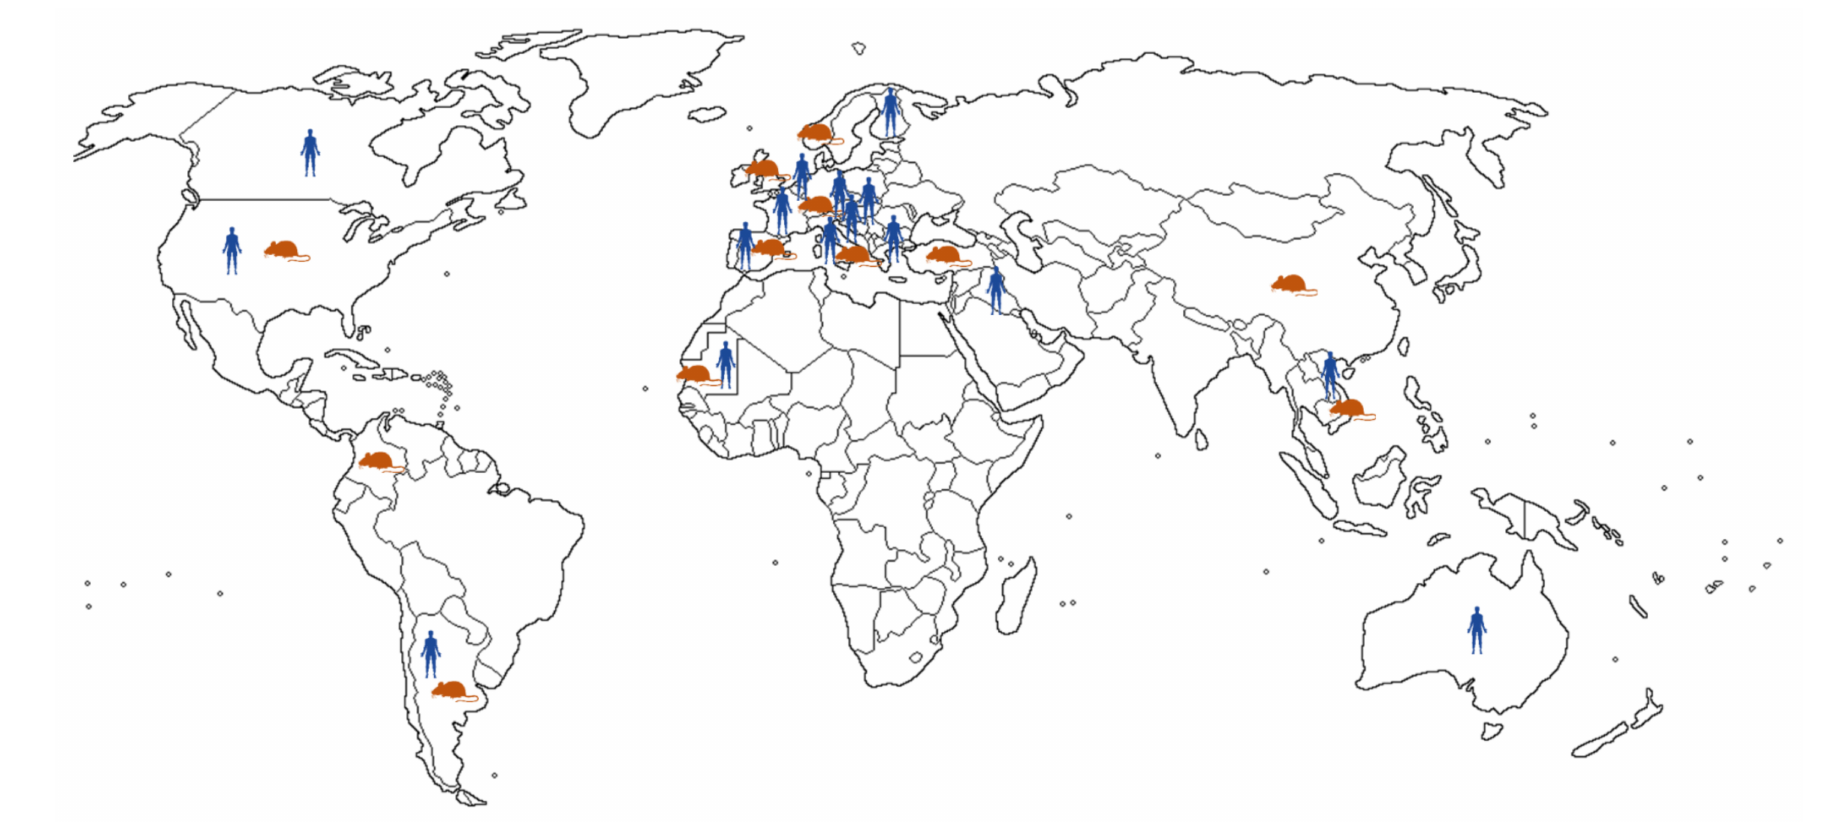
Figure 1. Geographic distribution of LCMV infections reported in humans and